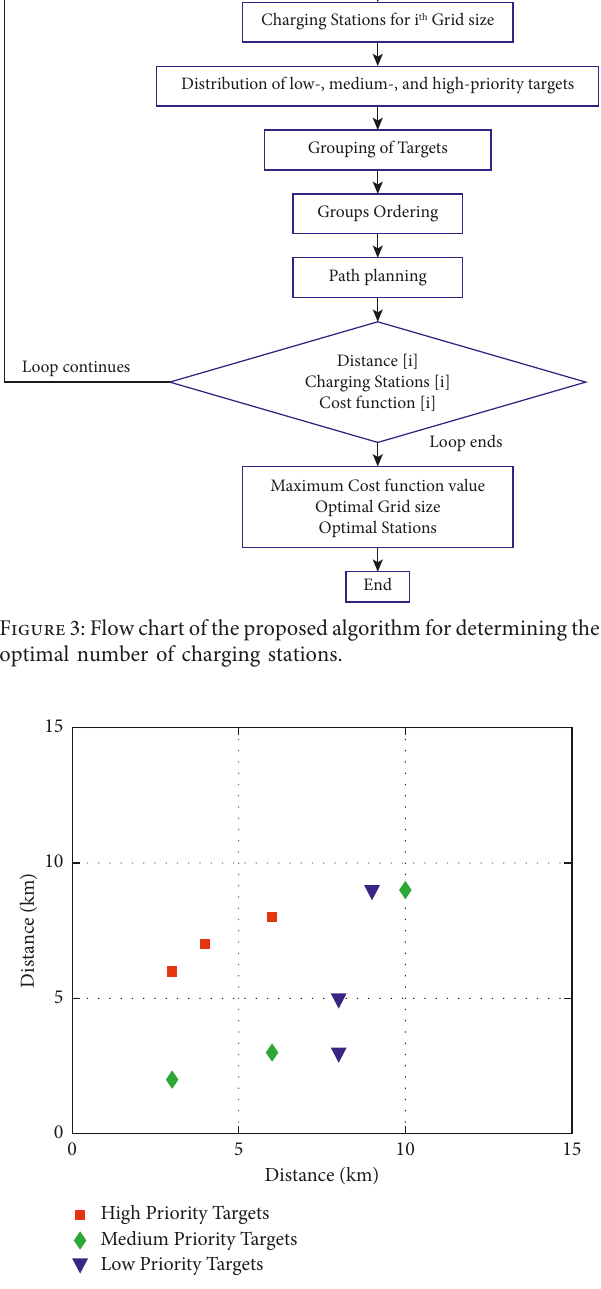
Figure 4: Random distribution of low-, medium-, and high-pri- ority targets.